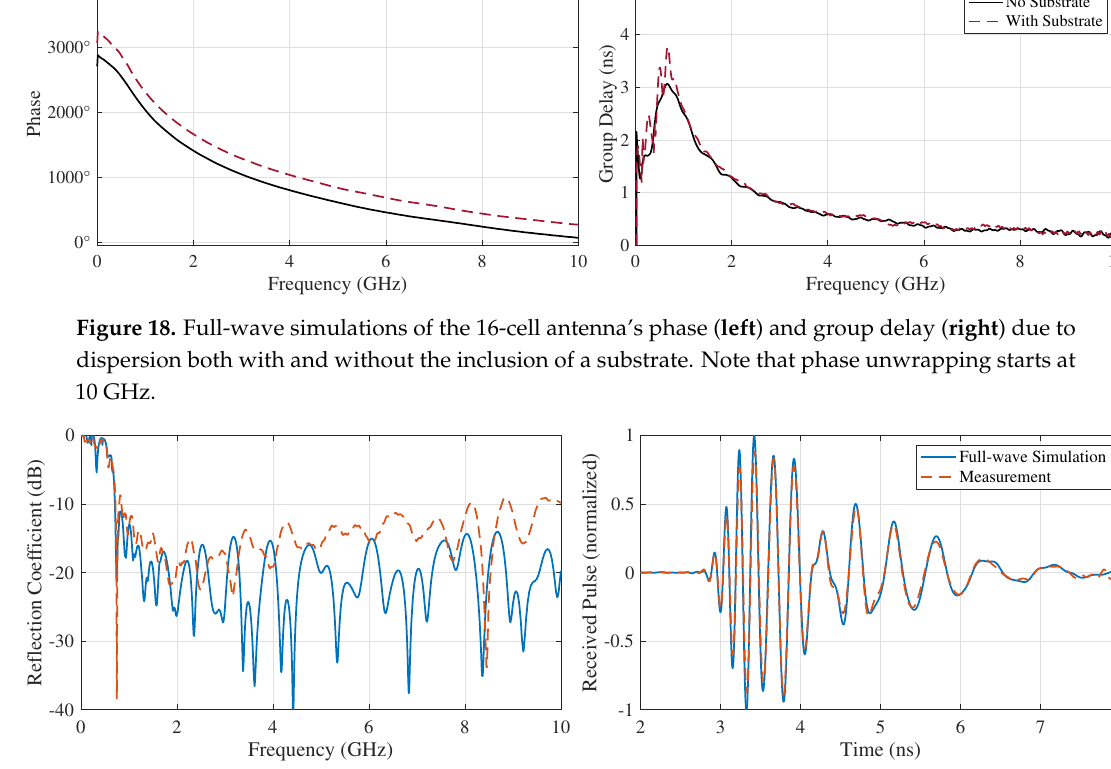
Figure 19. Full-wave simulation vs. measurement of the 16-cell antenna with tapered balun feed. Reflection coefficient comparison ( left ) and 2” sphere target return pulse ( right